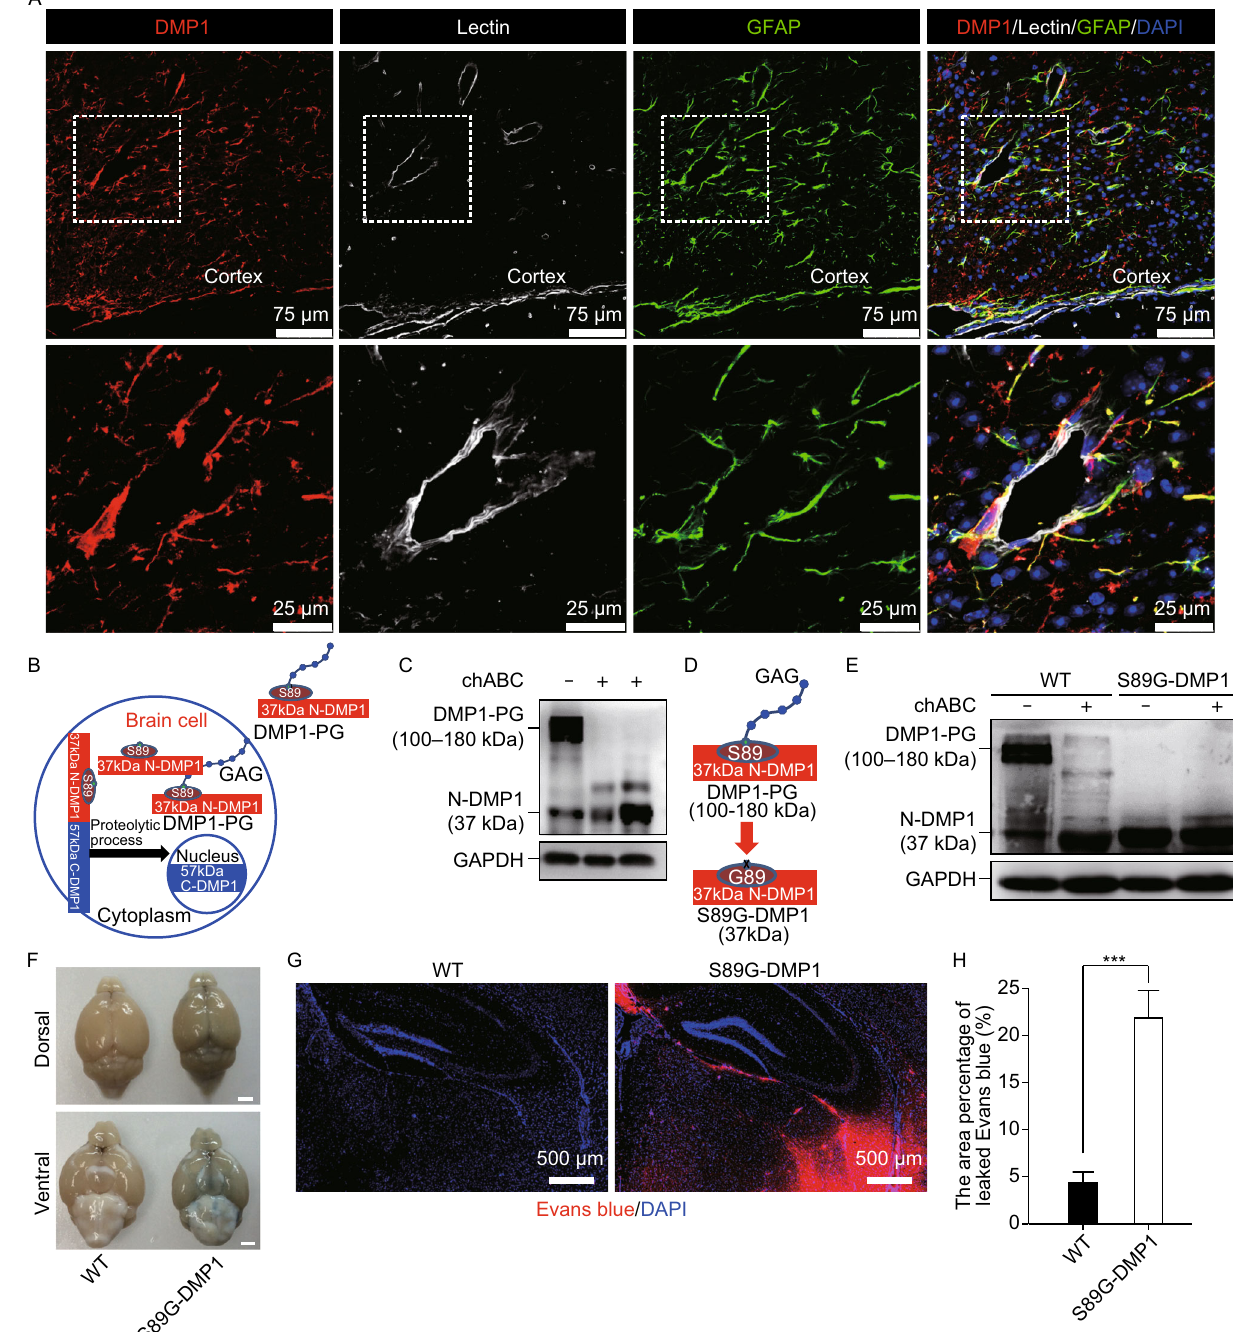
mineralization (George et al., 1995; Feng et al., 2006). We created brain-speci fi c conditional C-DMP1 knockout mice by crossing C-Dmp1 fl ox/ fl ox mice with Nestin-Cre transgenic mice. The brain-speci fi c knockout of C-DMP1, surprisingly, did not lead to BBB disruption (Fig. S1), suggesting that N-DMP1 (rather than C-DMP1) was important for BBB structure and/or